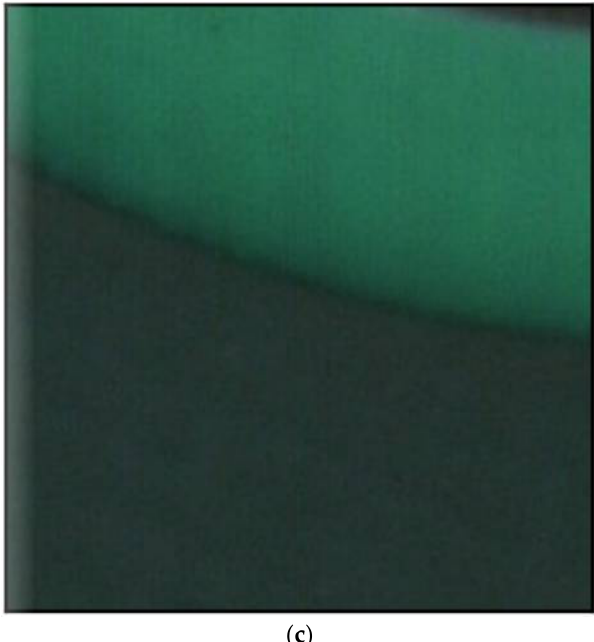
Figure 4. True negative PCB example. ( a ) True negative example 1; ( b ) True negative example 2; ( c ) True negative example 3.